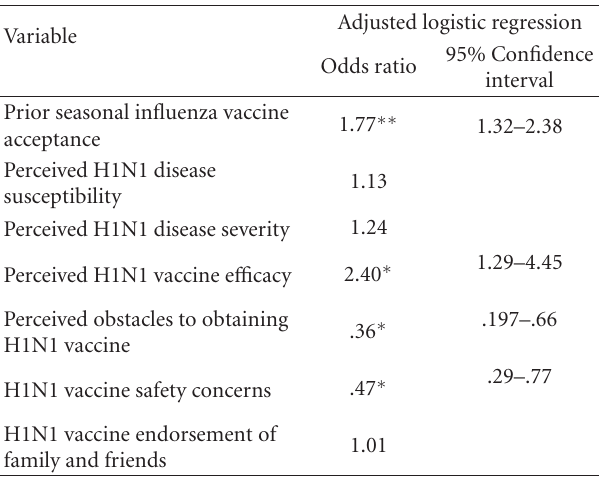
Table 1: Predictors of having received an H1N1 vaccine: final logistic regression model a